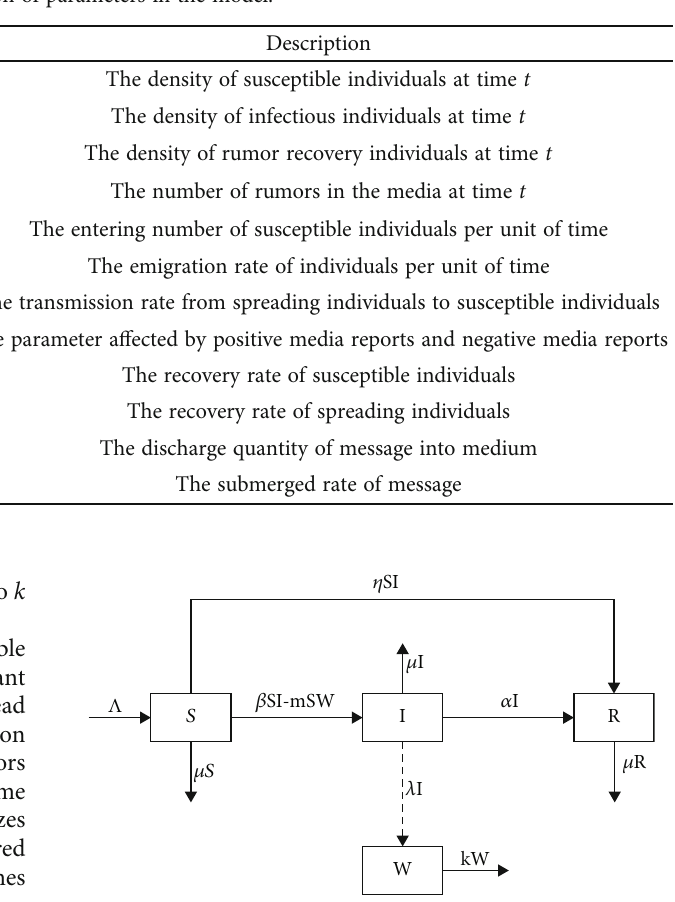
Table 1: Description of parameters in the model.